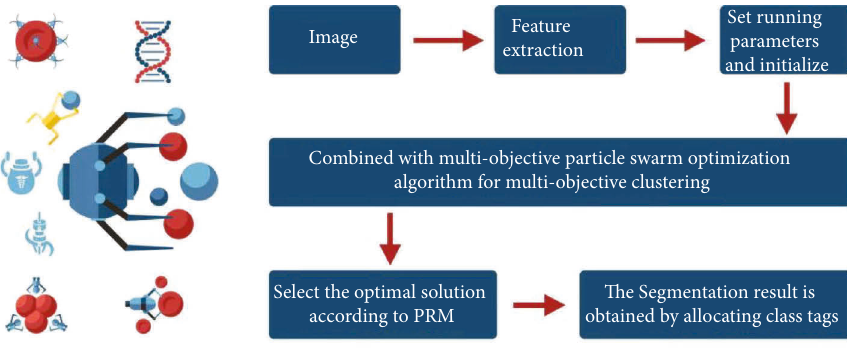
Figure 1: Particle swarm